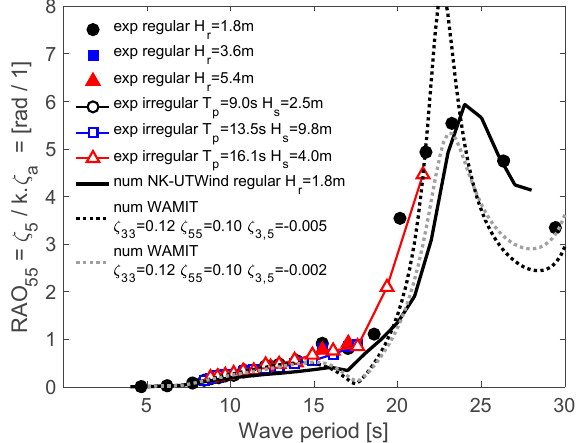
Figure 12. RAO pitch motion result comparisons between the experiment and numerical calculations.